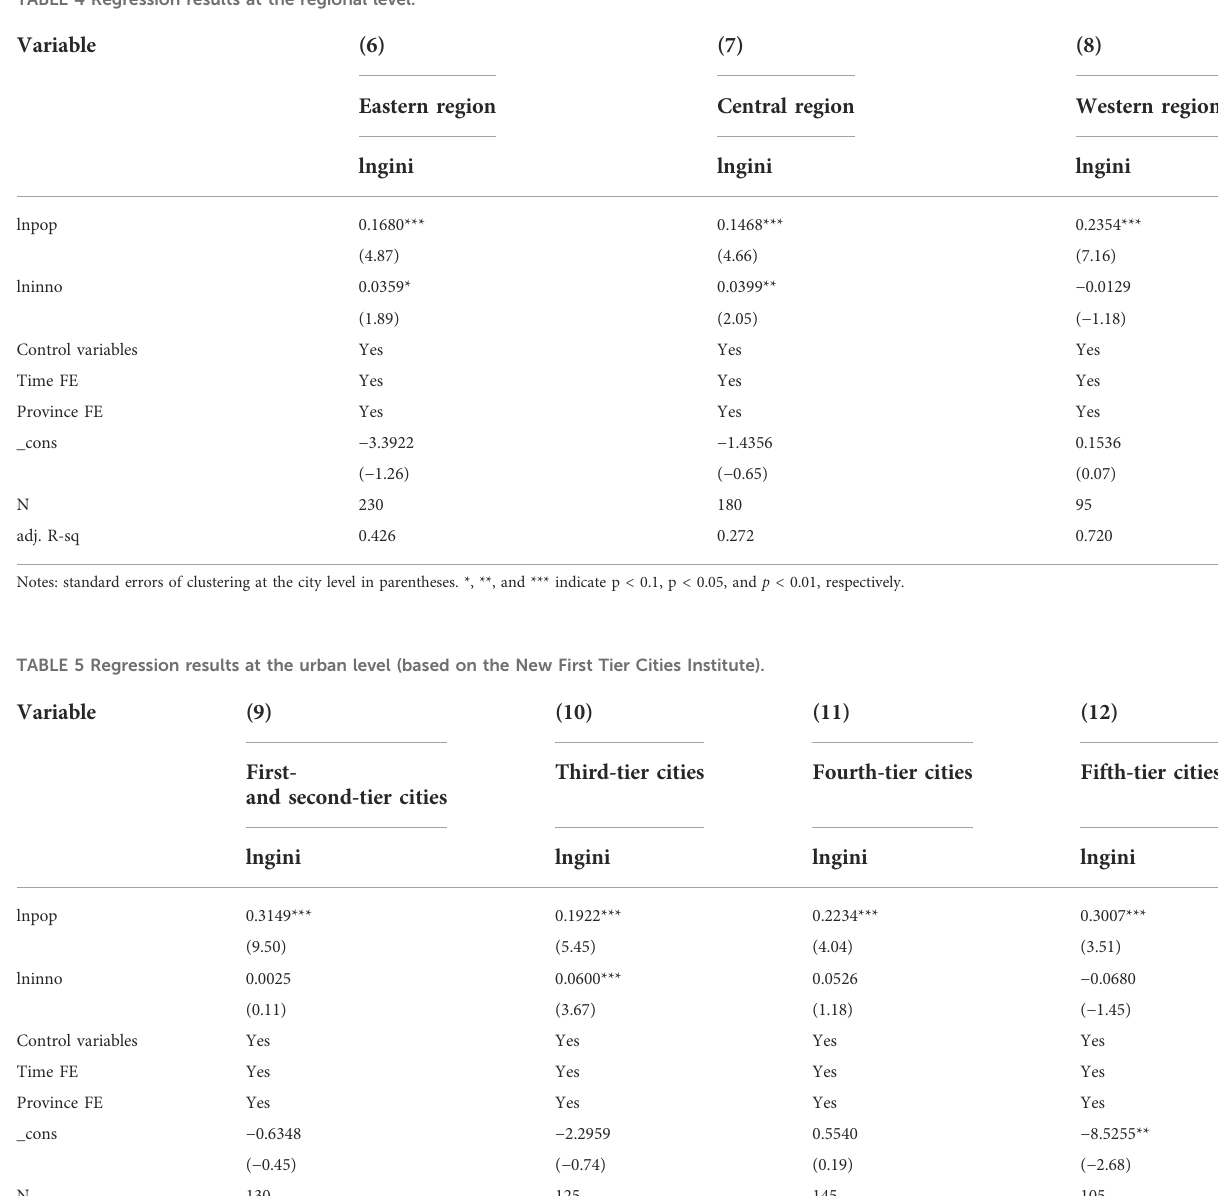
TABLE 4 Regression results at the regional level.